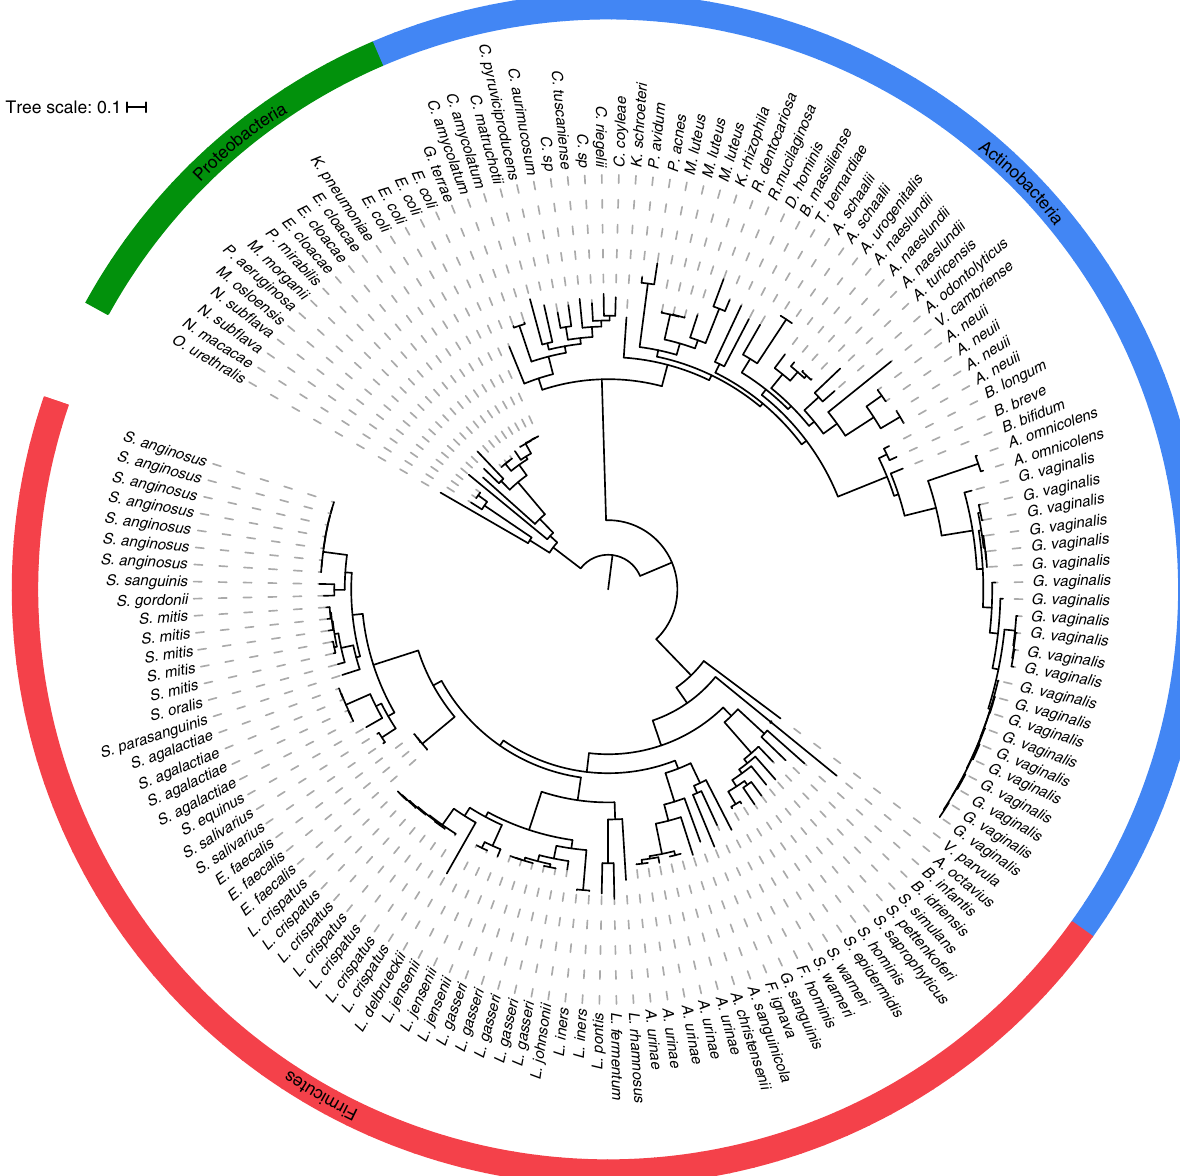
Fig. 1 Phylogenetic tree representing diversity of bacteria cultured from the female bladder. A representation of the full bacterial diversity ( n = 149 isolates) that can be isolated using the expanded quantitative urine culture (EQUC) method from catheterized urine samples ( n = 77